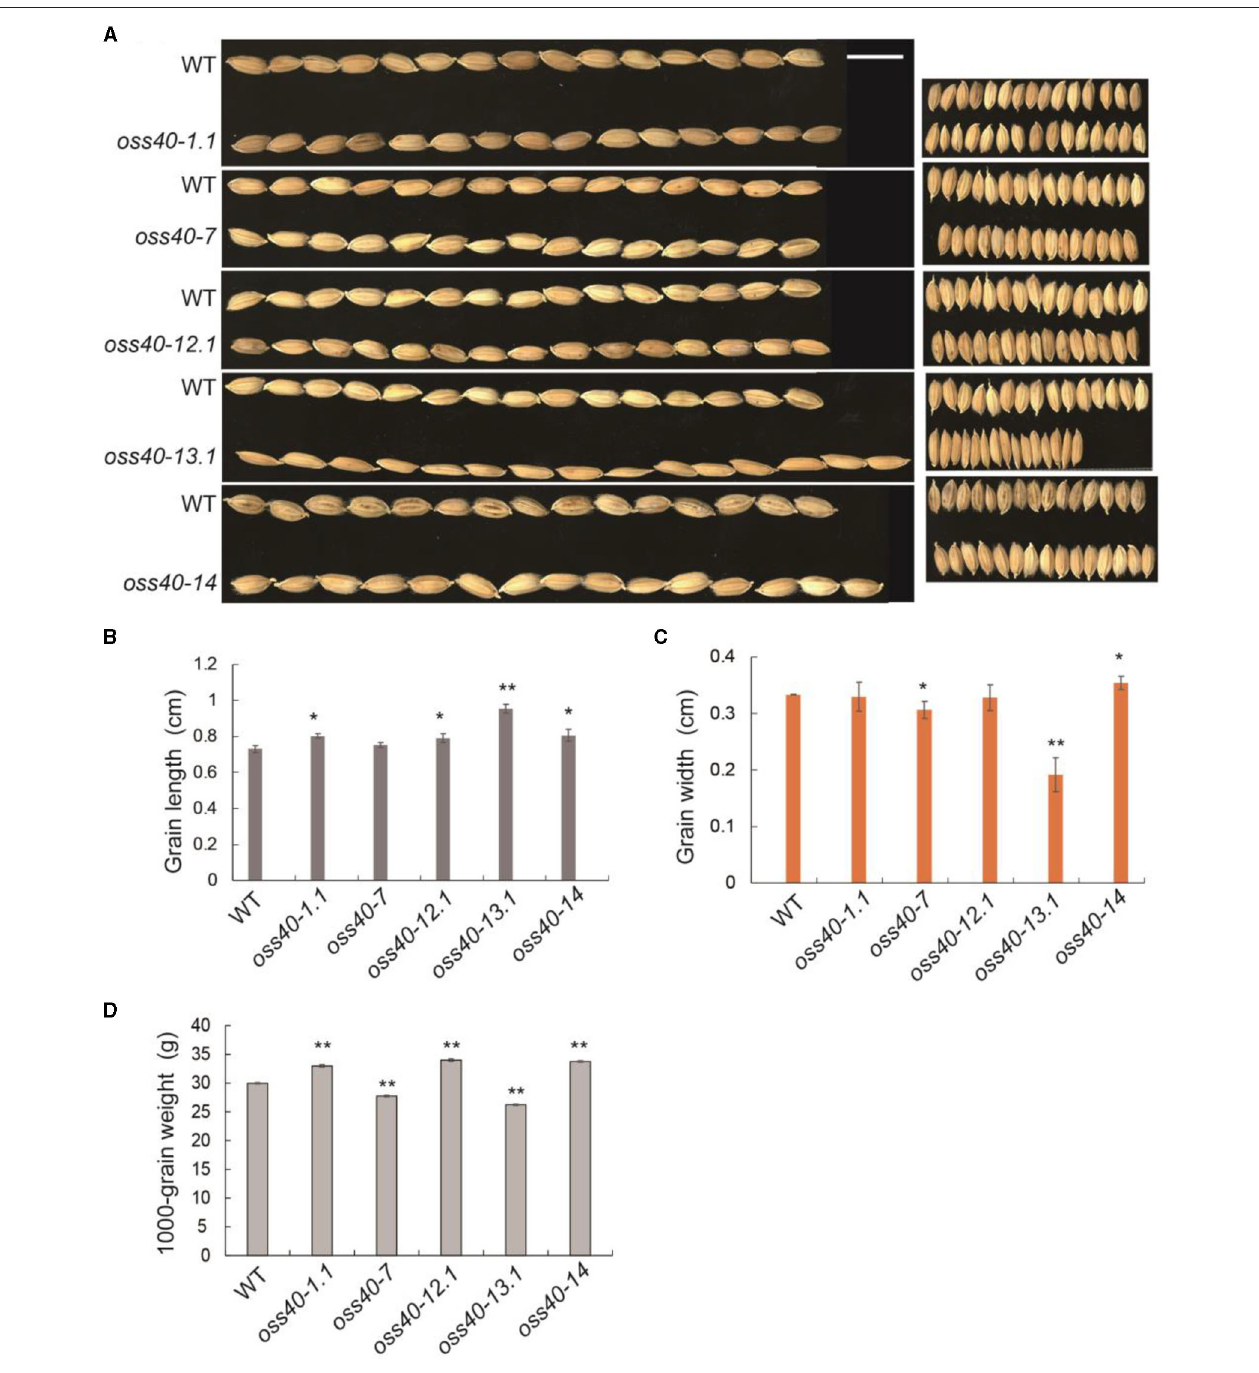
FIGURE 5 | Grain size and grain weight phenotypes of different oss40 mutant lines compared with WT (NIP) (A) . A representative grain phenotype of various oss40 mutants relative to WT. Scale bar = 10mm (B,C) . The grain length (B) and width (C) of 20 grains were randomly taken from various oss40 mutants relative to WT (D) . About 1,000-grain weight of various oss40 mutants relative to WT. The values are mean ± SD. Mean and SD values were obtained from three biological replicates and three technical replicates. Significant differences of the values normalized to WT were evaluated using Student’s t -test (* p < 0.05; ** p < 0.01).